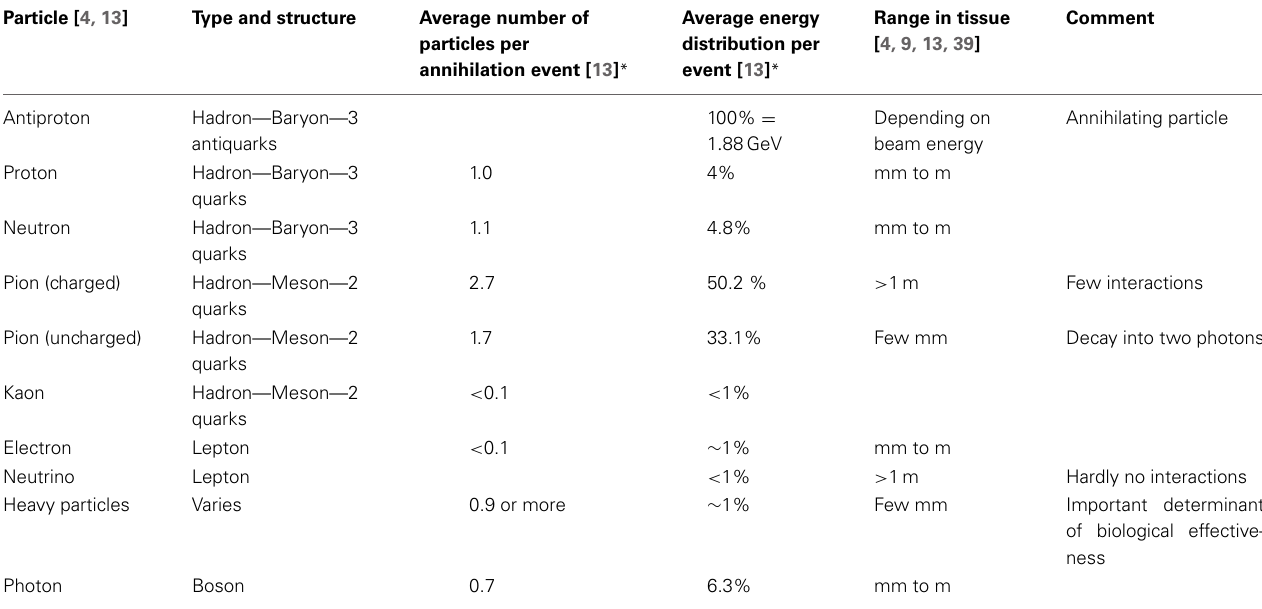
Table 1 | Overview of important particles involved in antiproton radiotherapy. Particle [4,